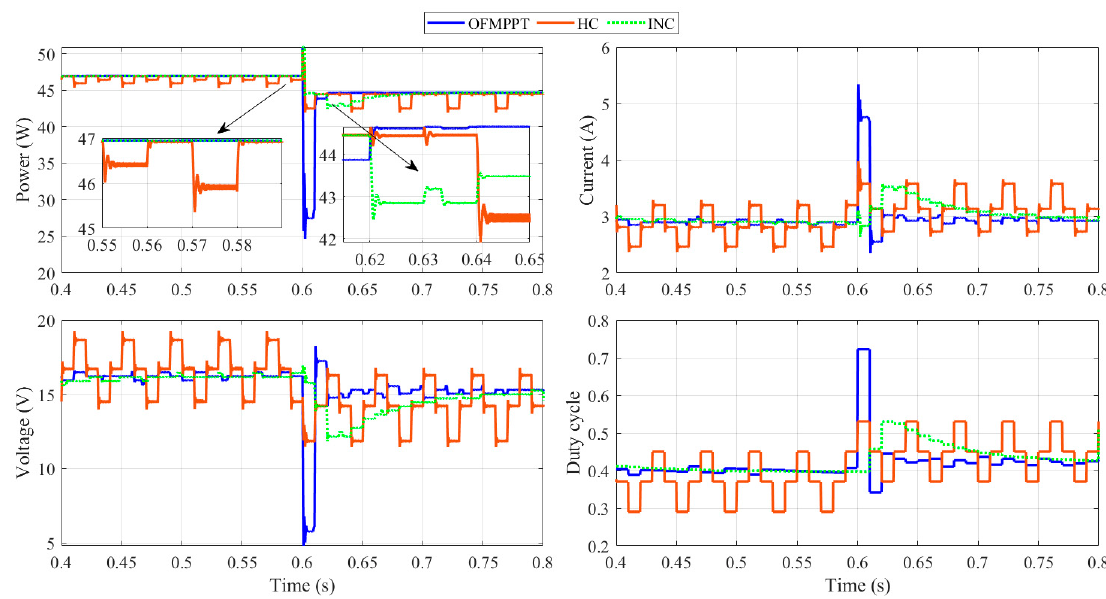
Figure 13. Dynamic tracking performance using OFMPPTS, HC, and INC methods for 4th scenario.